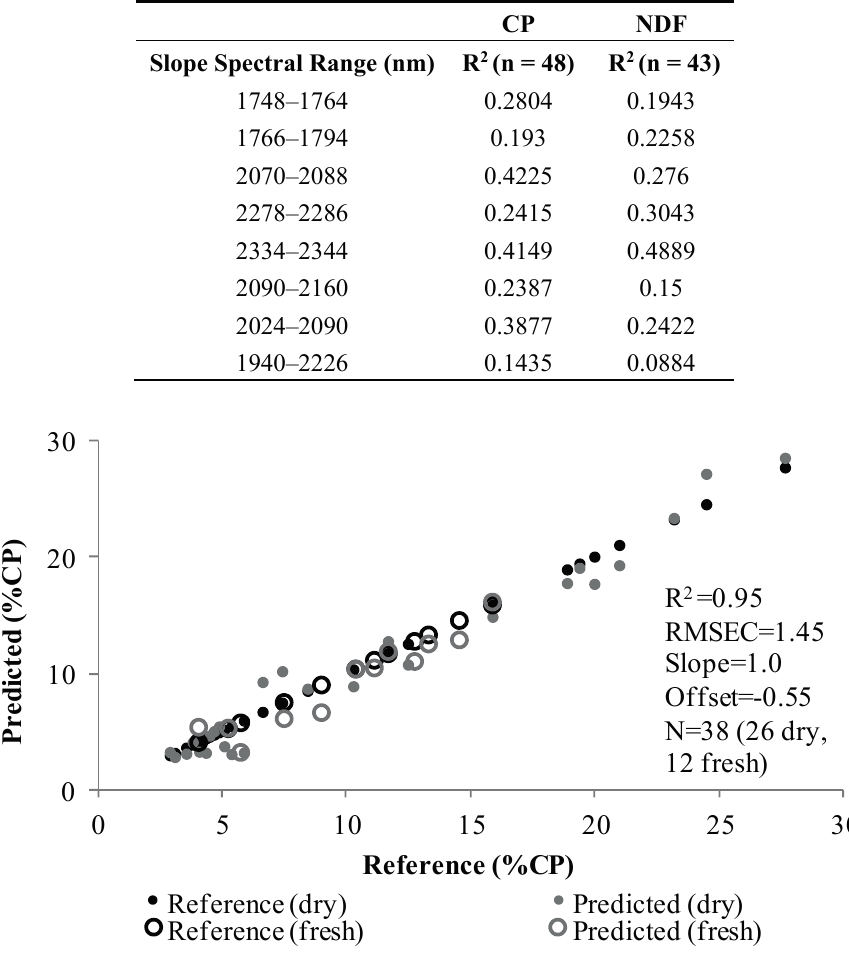
Figure 5. Crude protein (CP) distribution from predicted (external test data) vs. reference values of fresh and dry vegetation using partial least squares (PLS)